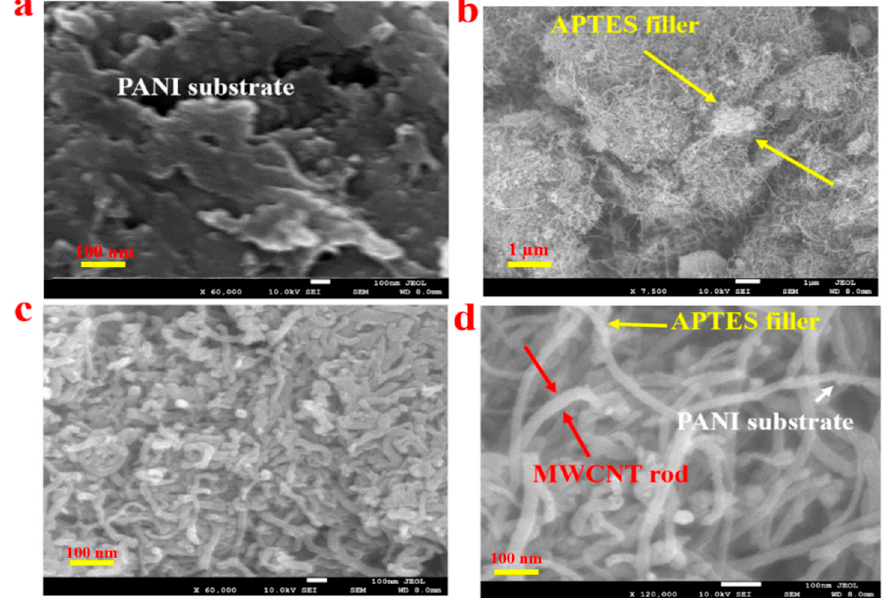
Figure 1. Scanning electron microscope images of ( a ) the PANI matrix, ( b ) the PANI-APTES com- posite, and ( c ) PANI-APTES-MWCNTs and ( d ) a magnified image of